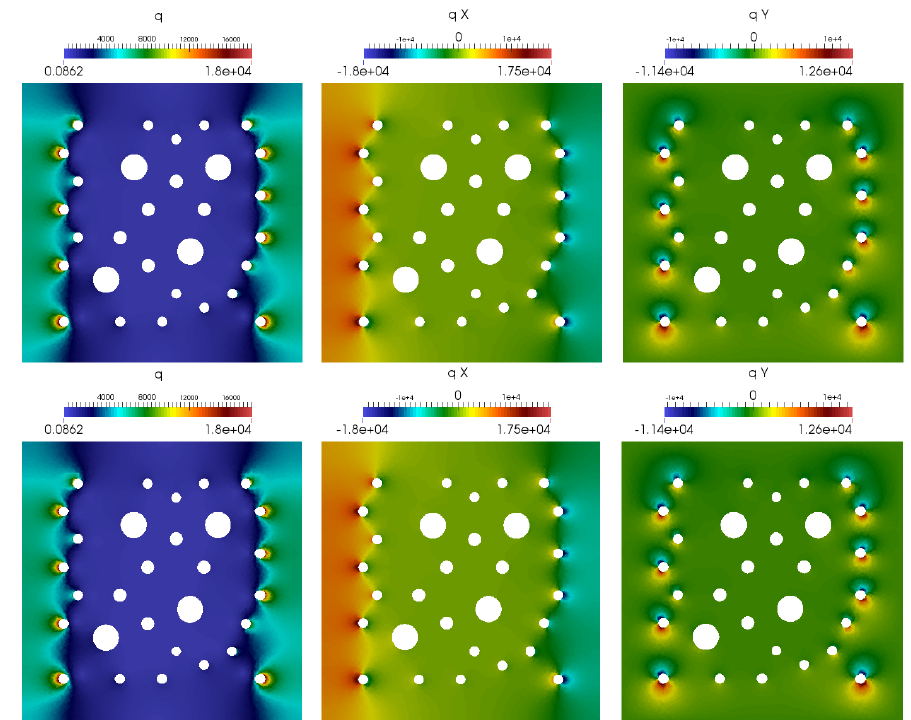
Figure 6. The distribution of the flux. Magnitude of flux, x and y components of flux, q , q x , q y (from left to right). ( Top ): Reference (fine grid) solution, DOF f = 155,580. ( Bottom ): Multiscale solution, DOF c = 980 (0.48% from DOF f ).